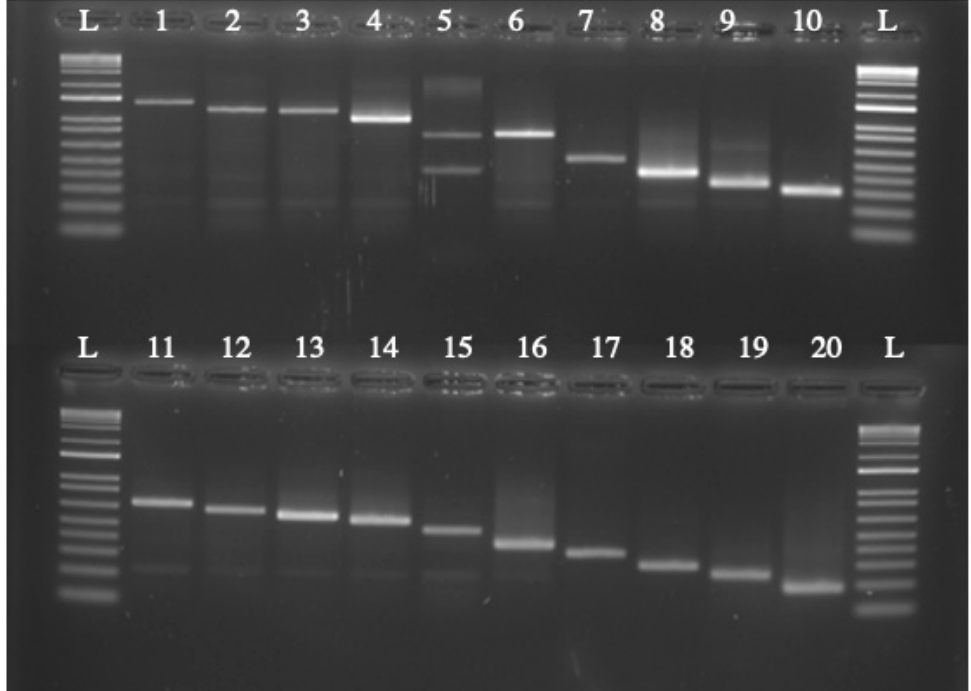
Figure 6. Identification of insertion site of 50:1 ratio of A. tumefaciens to C. glabrata transformants using vectorette PCR. (A). To confirm that increasing the ratio of A. tumefaciens to C. glabrata did not cause double insertions vectorette PCR was used to identify the insertion sites. One out of twenty samples showed a double insertion (Lane 5), meaning multiple insertions occurred at a 5% rate. The samples were flanked on each side with a 1.0 Kb Plus ladder size standard (L) (New England Biolabs, Ipswich, MA, USA).